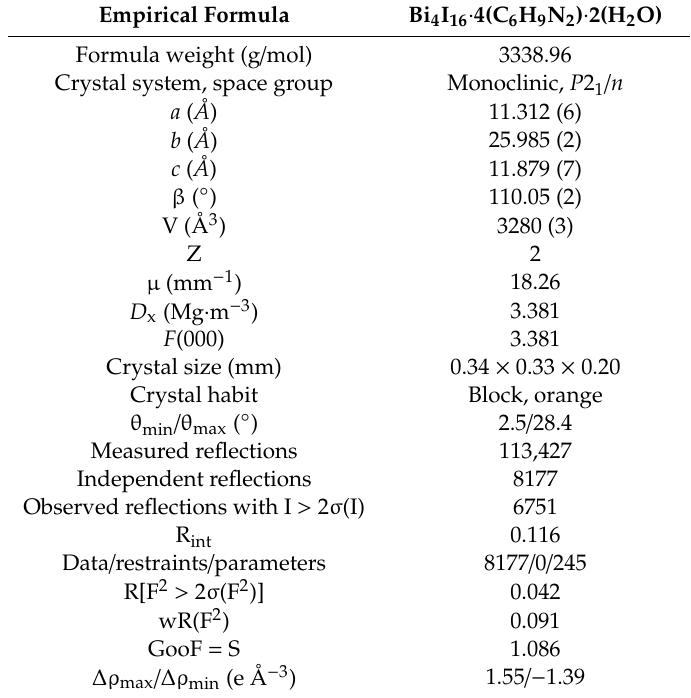
Table 1. Crystallographic data and structure refinement parameters for Bi 4 I 16 · 4(C 6 H 9 N 2 ) 2(H 2 O).